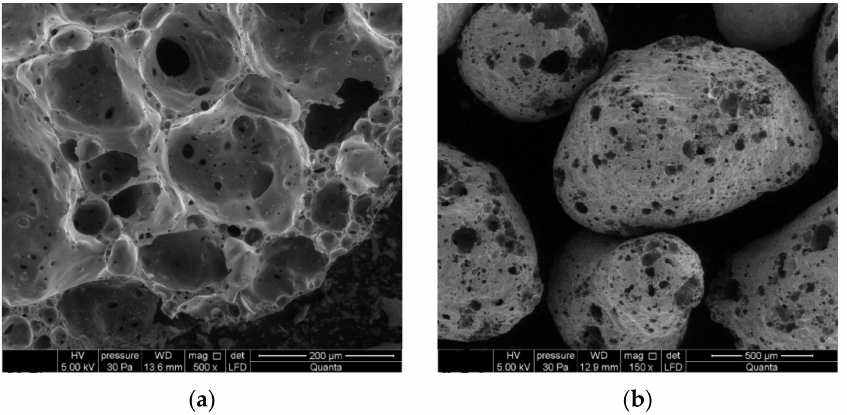
Figure 1. Expanded granulated foam glass—SEM pictures (x250): ( a ) granulate surface, ( b ) cross- section of the